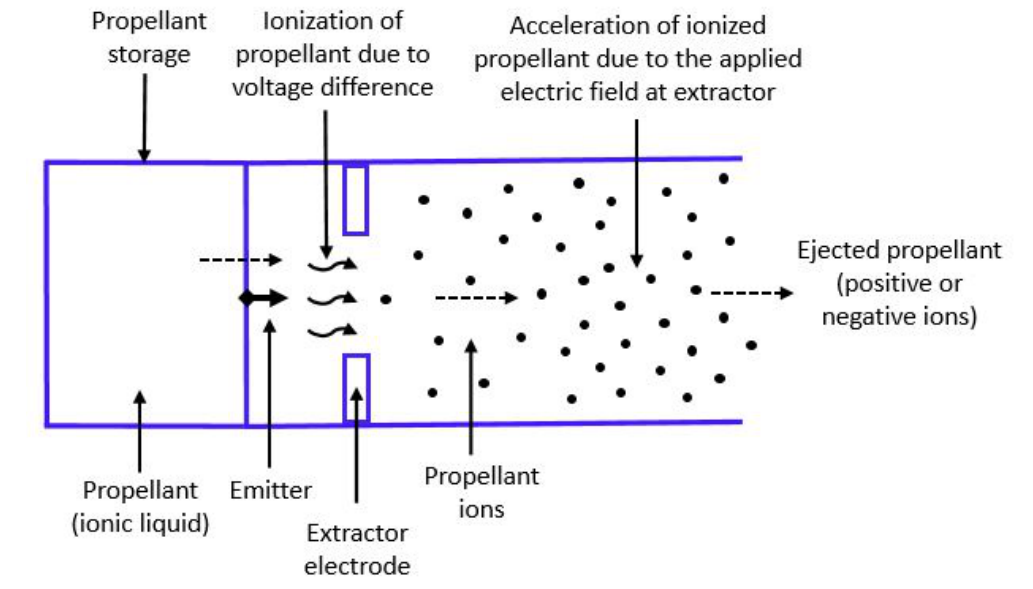
Figure 7. Schematic of an Electrospray Propulsion